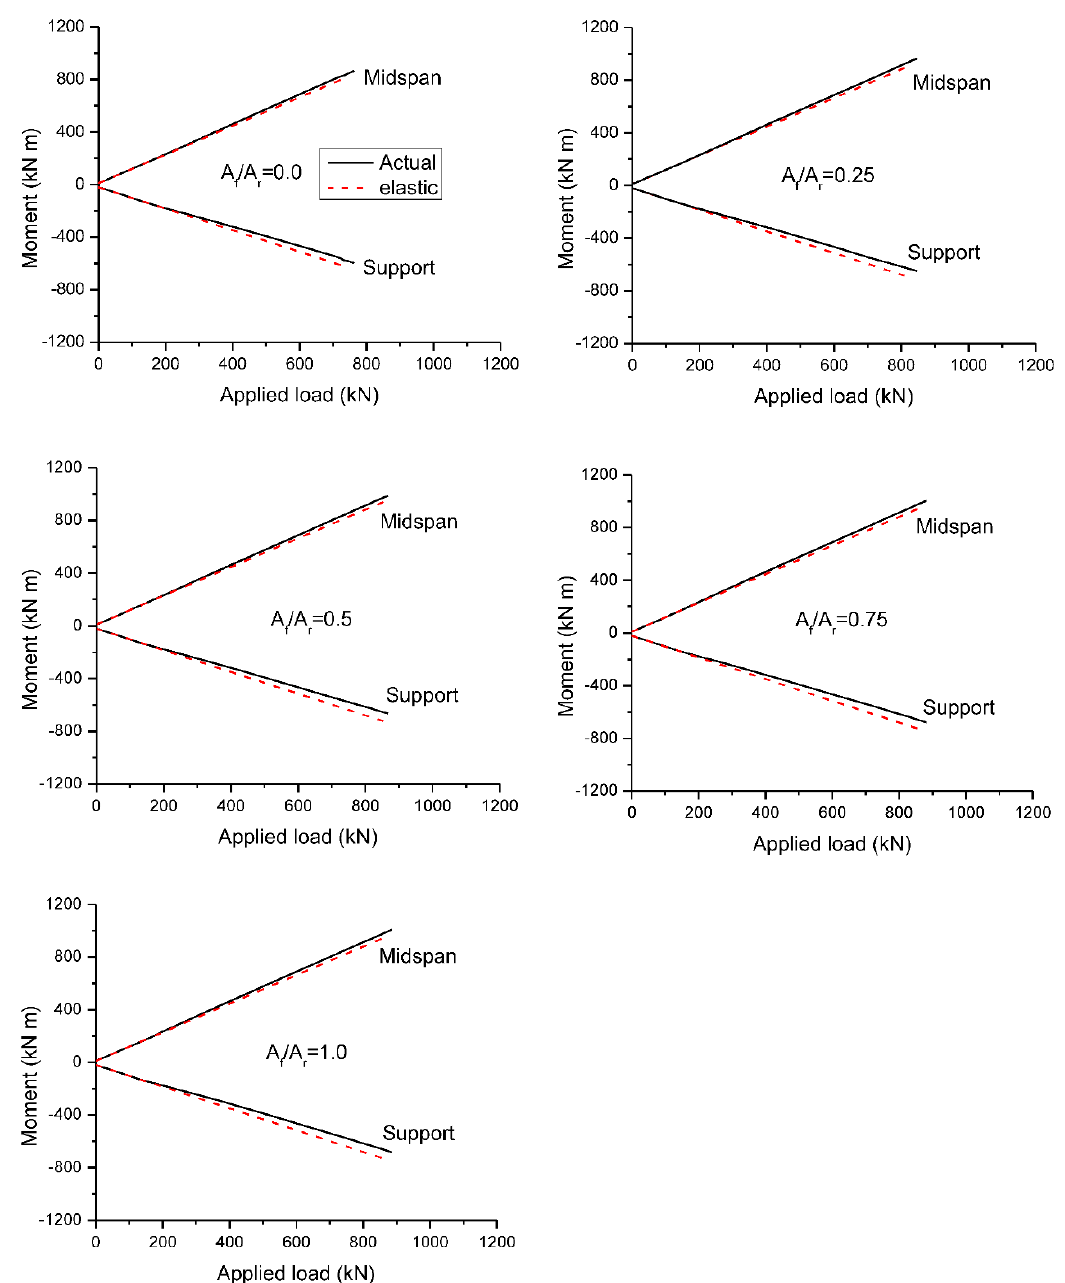
Figure 13. Load-moment behavior at unsymmetrical